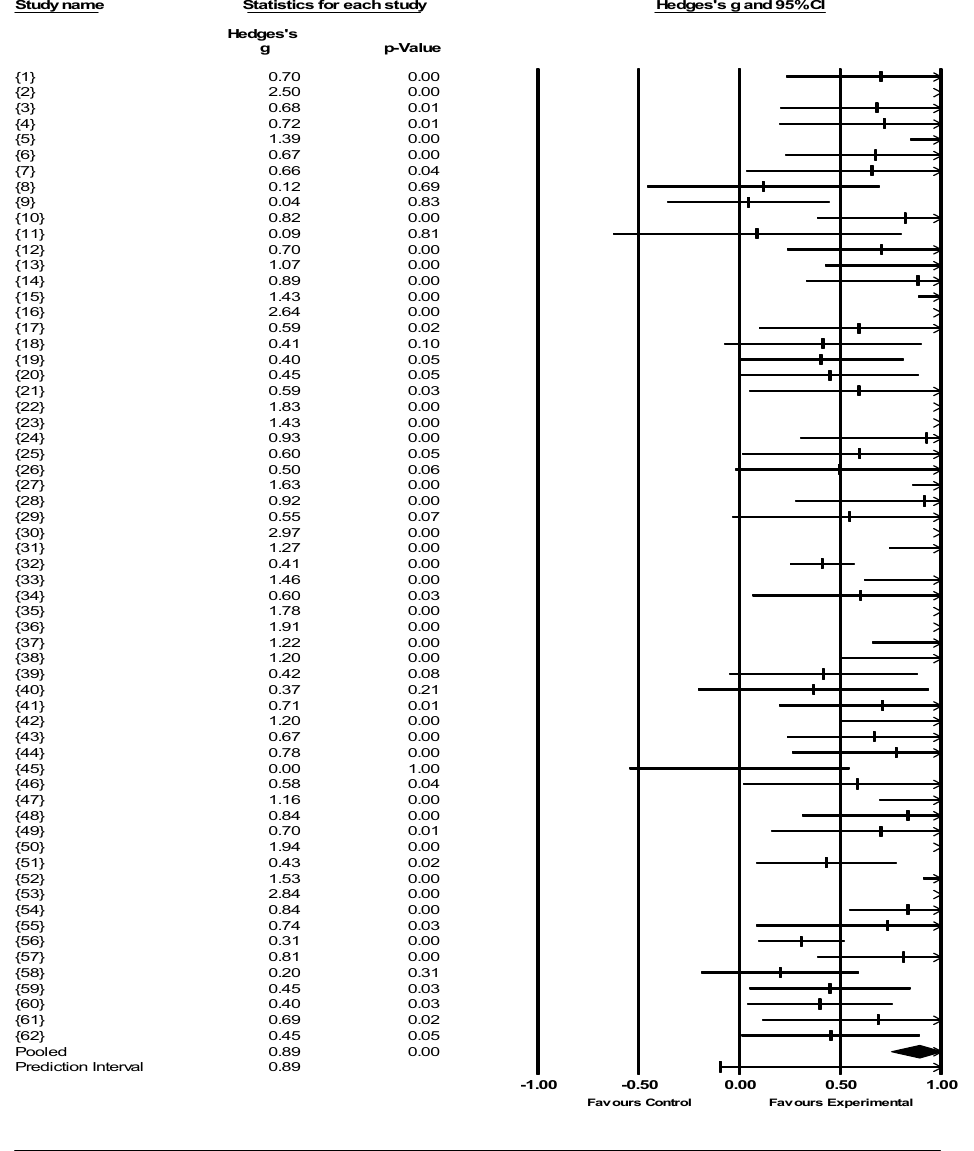
Figure 2. Summary of the studies’ statistics.